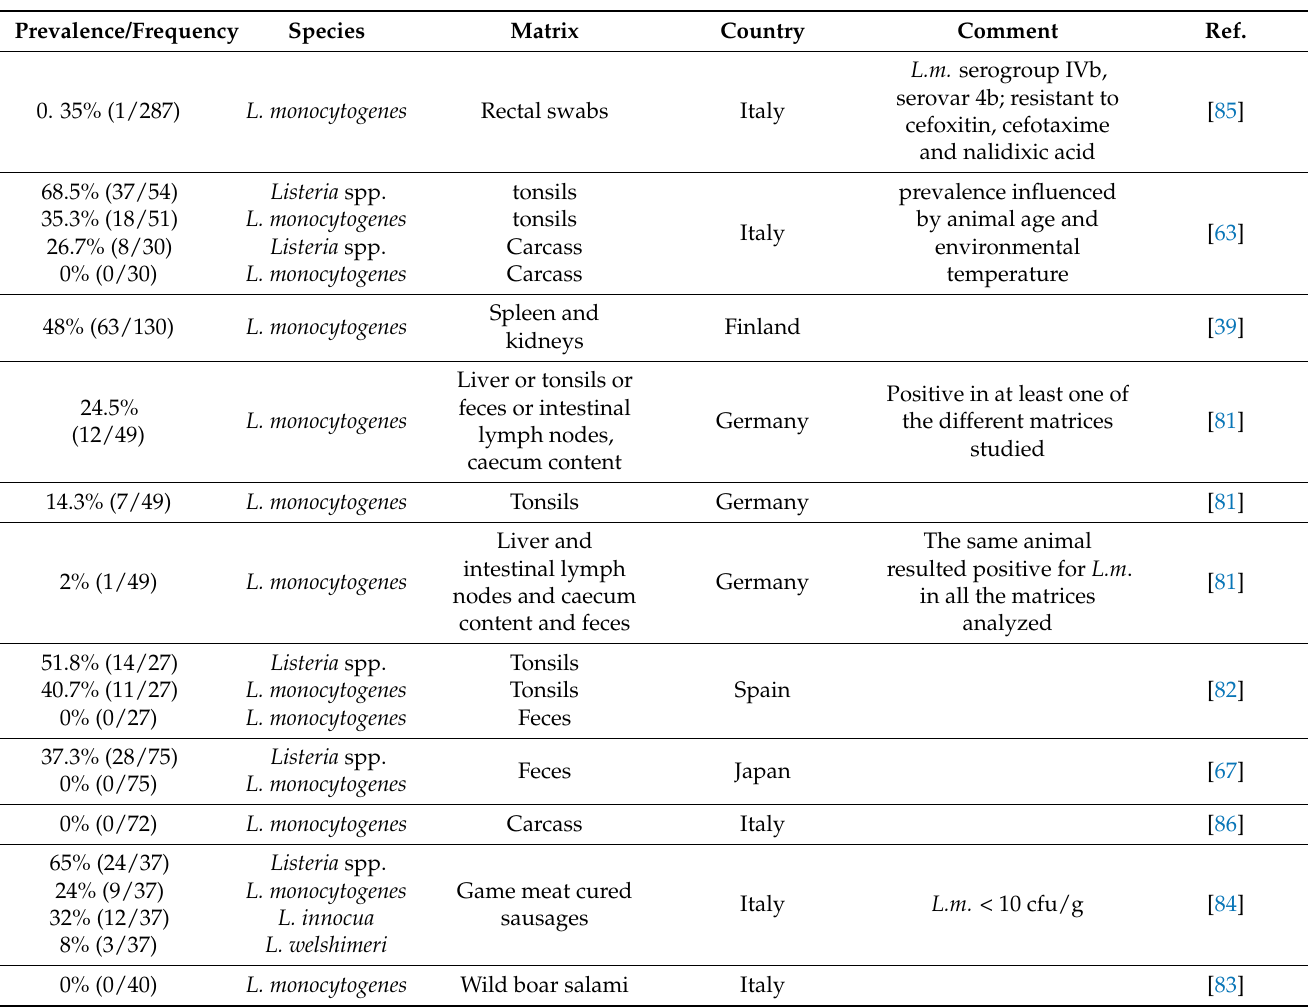
Table 6. Presence of Listeria sp. in wild boar,